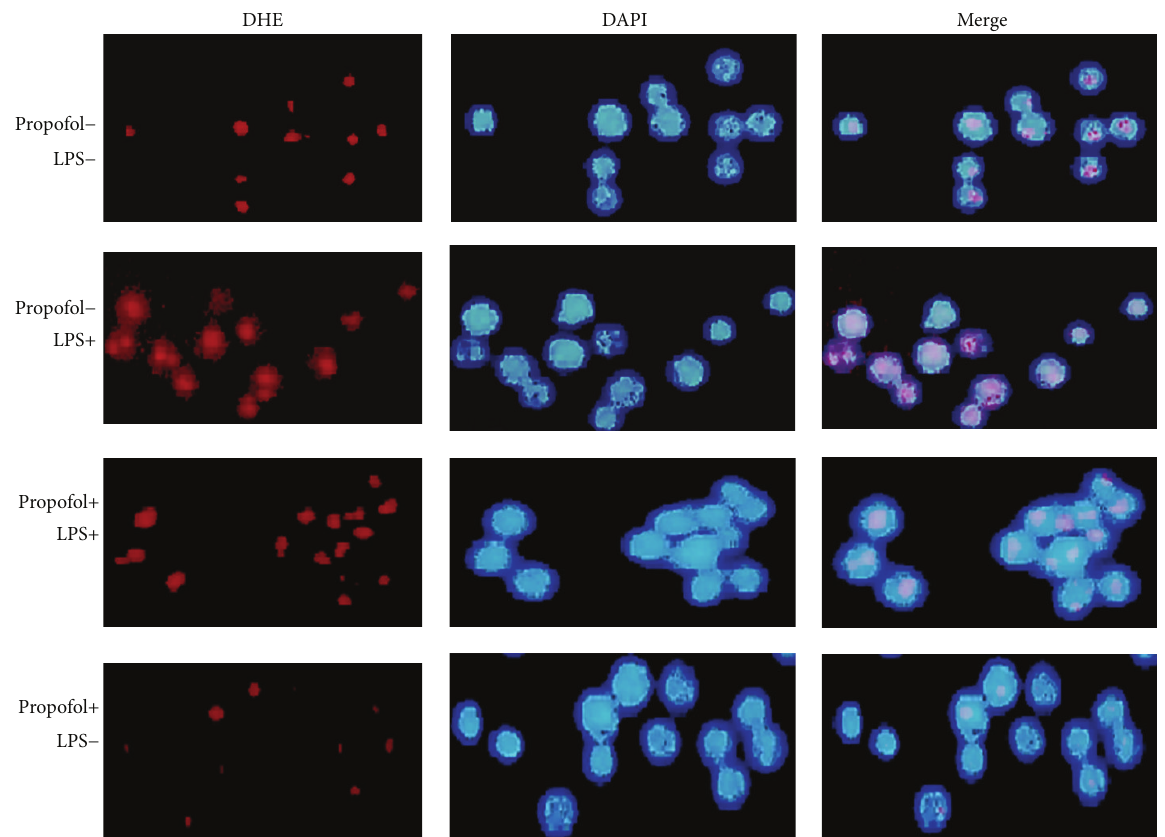
Figure5:EffectofpropofolpretreatmentonLPS-inducedgenerationofROS.Aftera40 minincubationfollowing50 𝜇 Mpropofolordimethyl sulfoxide (DMSO) treatment, cells were stimulated with LPS for 40min then stained with 2 𝜇 M dye hydroethidine (DHE) and incubated for 30 min at 37 ∘ C in the dark. Nuclei were stained with DAPI.